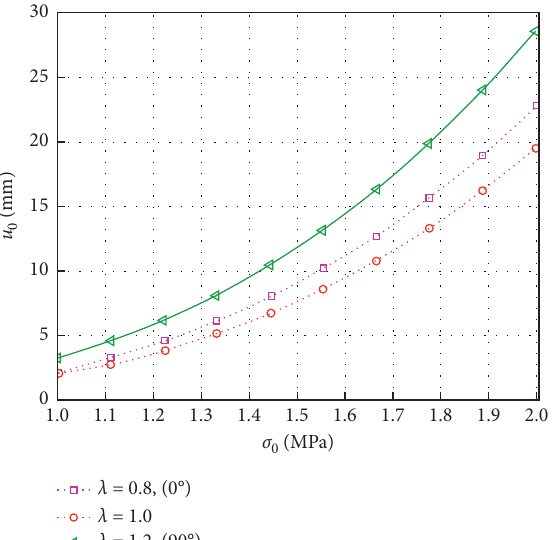
Figure 6: Effect of the maximum surface displacement of surrounding rock with burial depth. Parameter values: v � v α � 0 ,E � E r � 5GPa, and β r � 3 . 0